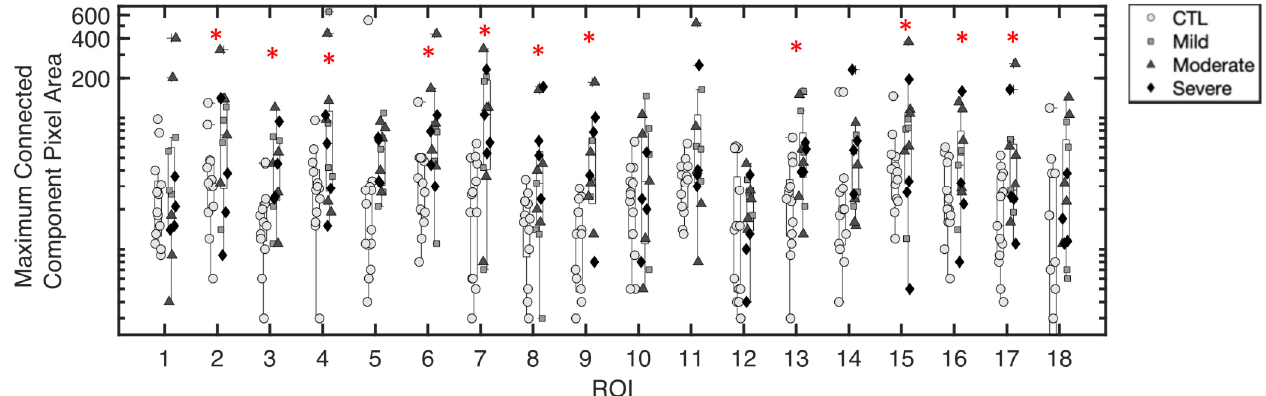
Figure 6. Maximum connected component pixel area per ROI in control and CF subjects. ROIs 1–9 are from the right lung and ROIs 10–18 are from the left lung. Red asterisks denote a statistically significant increase in CF subjects when compared to controls ( p < 0.05). Maximum connected component pixel area is plotted in log scale.